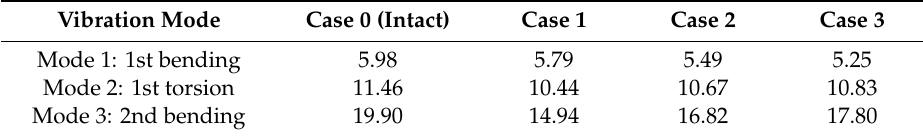
Table 3. Vibration frequencies of slab models (Unit: Hz).